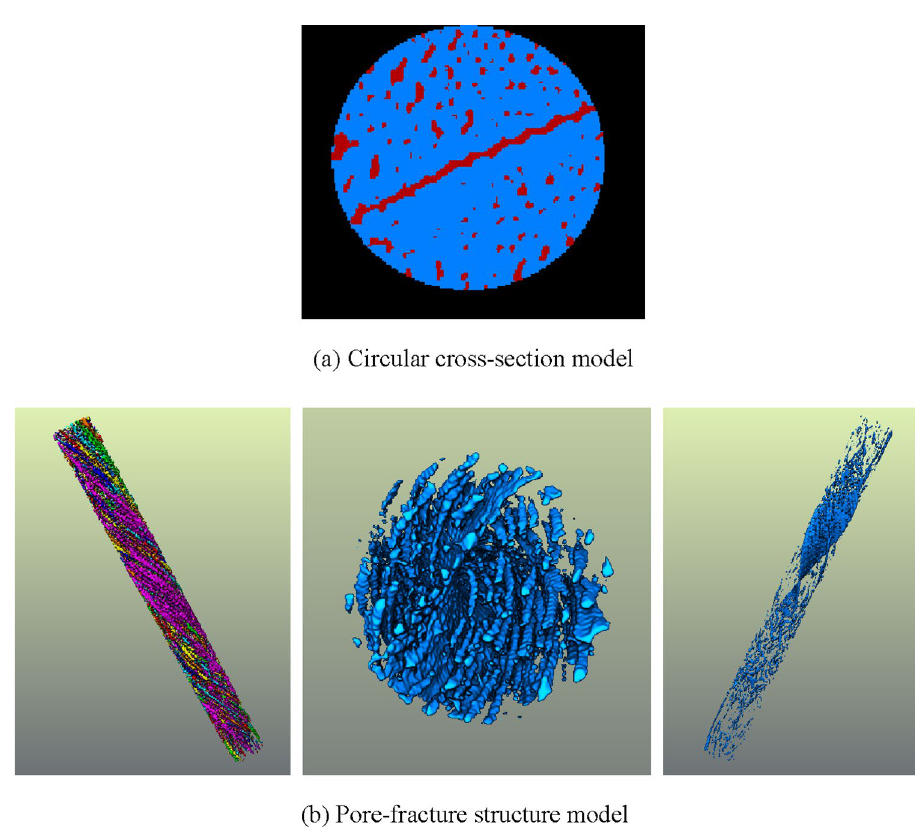
Figure 16. Three-dimensional distribution of the nylon-uncured rubber